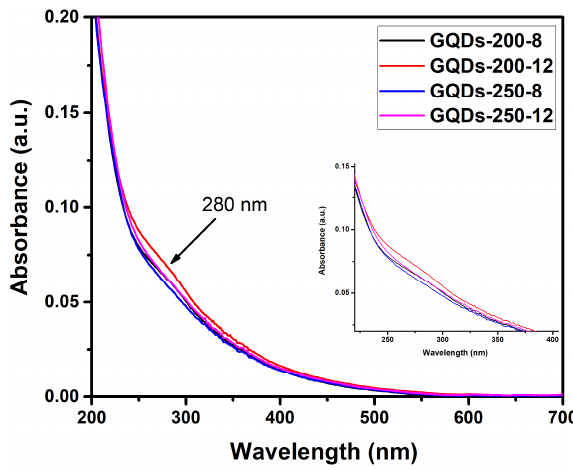
Figure 2. Ultraviolet–visible (UV–Vis) spectra of GQDs-200-8, GQDs-200-12, GQDs-250-8 and GQDs-250-12 showing a noticeable absorption peak at about 280 nm.